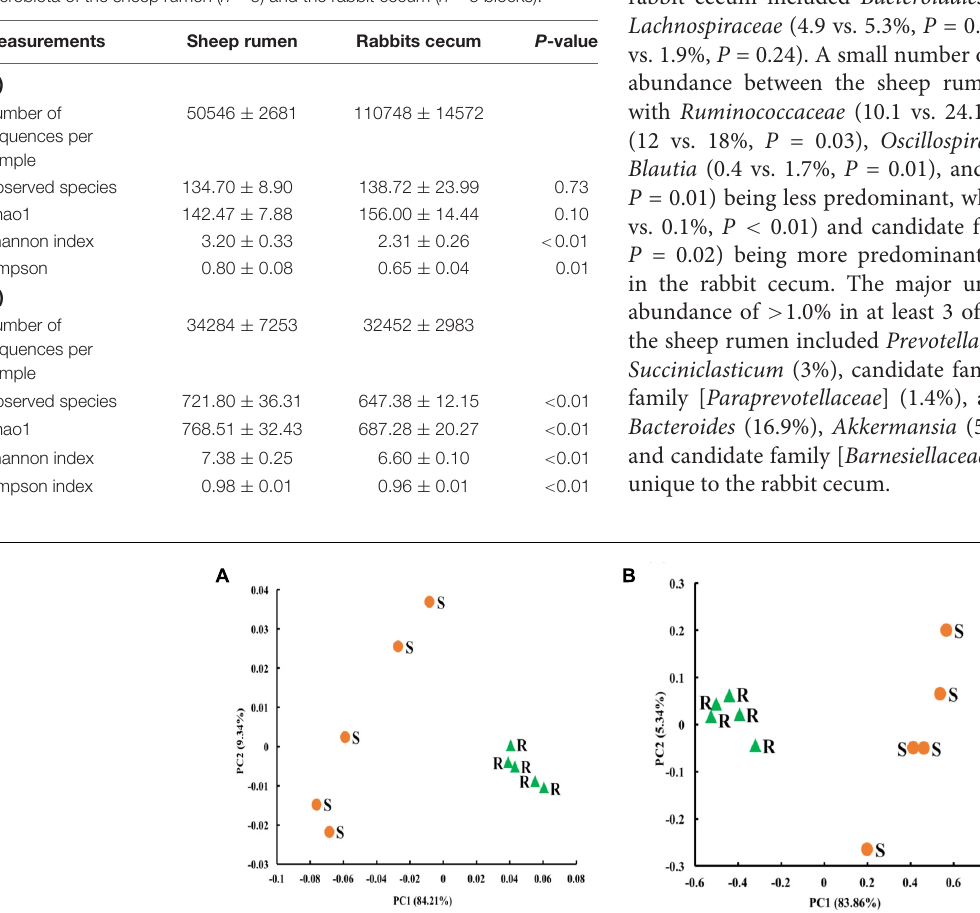
FIGURE 3 | Principal coordinates analysis (PCoA) plots in the sheep rumen ( n = 5) and the rabbit cecum ( n = 5 blocks). (A) Archaeal microbiota; (B) Bacterial microbiota. The PCoA were based on distance matrices generated using weighted UniFrac. S, sheep rumen samples; R, rabbits cecal samples.